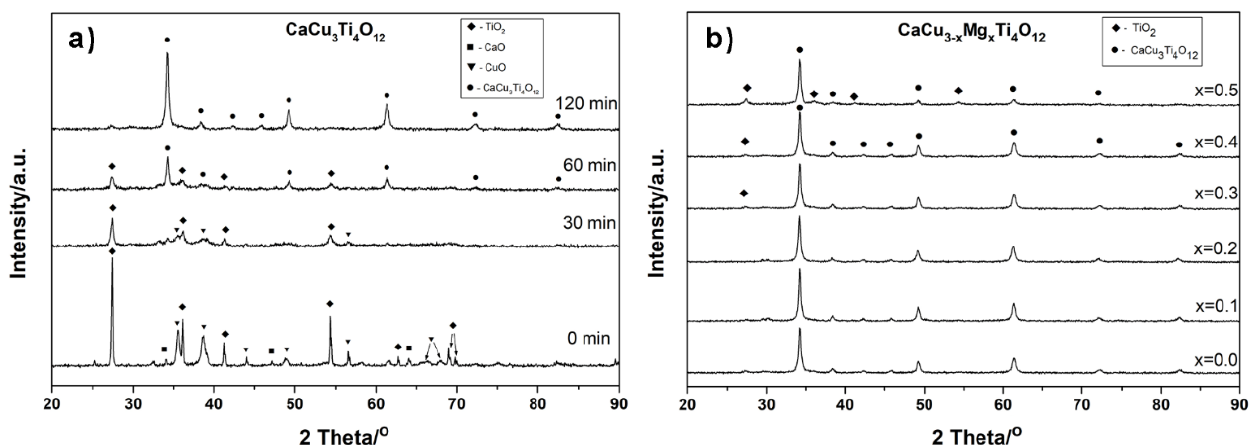
Figure 1. XRD diffraction patterns of: ( a ) substrate powders after different times of mechanochemical processing; ( b ) CaCu 3−x Mg x Ti 4 O 12 solid solutions with 0.1 ≤ x ≤ 0.5, prepared by the mechanochemical synthesis method.